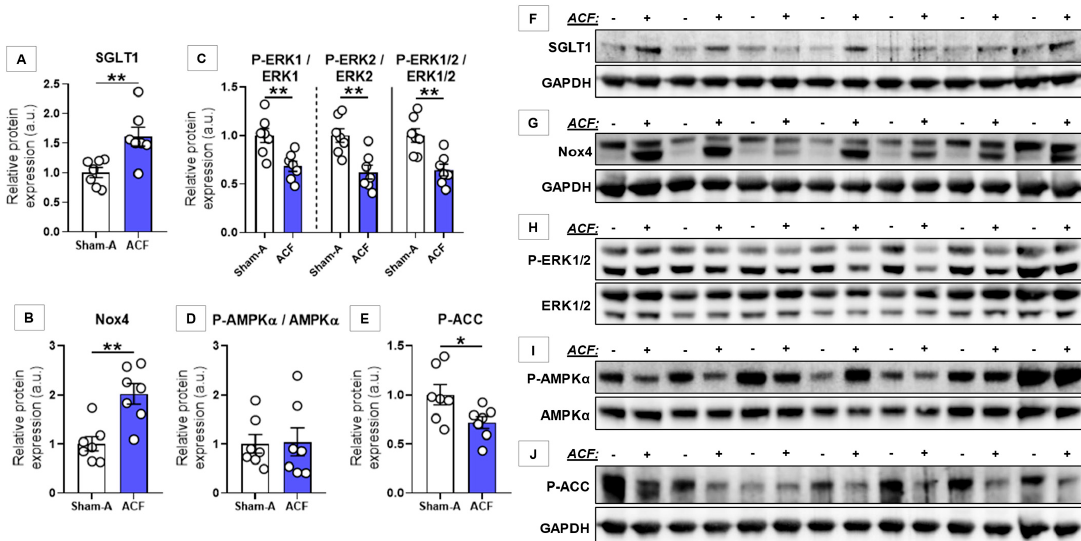
Figure 3. Western blot analysis of left ventricular samples from sham-operated and volume-overloaded rats with heart failure. ( A–E ) Relative protein expression of left ventricular (LV) sodium-glucose cotransporter 1 (SGLT1); nicotinamide adenine dinucleotide phosphate (NADPH) oxidase isoform Nox4; phosphorylated extracellular matrix-regulated protein kinase 1 and 2 (P-ERK1/2; Thr202/Tyr204), and total ERK1 and 2 ratio separately and in combination; phosphorylated adenosine monophosphate-activated protein kinase α subunit (P-AMPK α ; Thr172) and total AMPK α ratio; and phospho- rylated acetyl coenzyme-A carboxylase (P-ACC; Ser79). ( F–J ) Cropped full-length blots according to the quantification. Following normalization to corresponding housekeeping (GAPDH), protein expression data were normalized to the mean of the respective Sham group to depict fold changes. * p < 0.050, ** p <